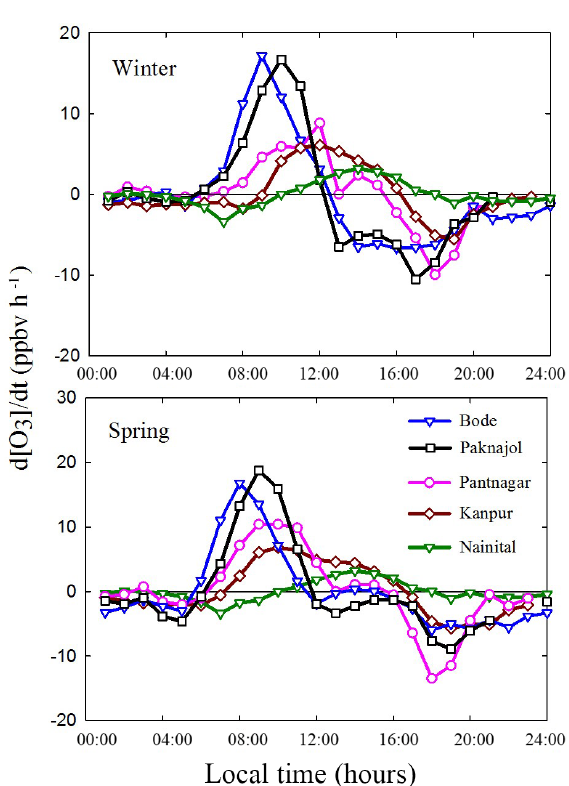
Figure 12. Diurnal variations in the average rate of change of ozone during winter and spring 2013 at Bode (blue), Paknajol (black; Put- ero et al., 2015), Pantnagar (pink), Kanpur (brown; Gaur et al., 2014) and Nainital